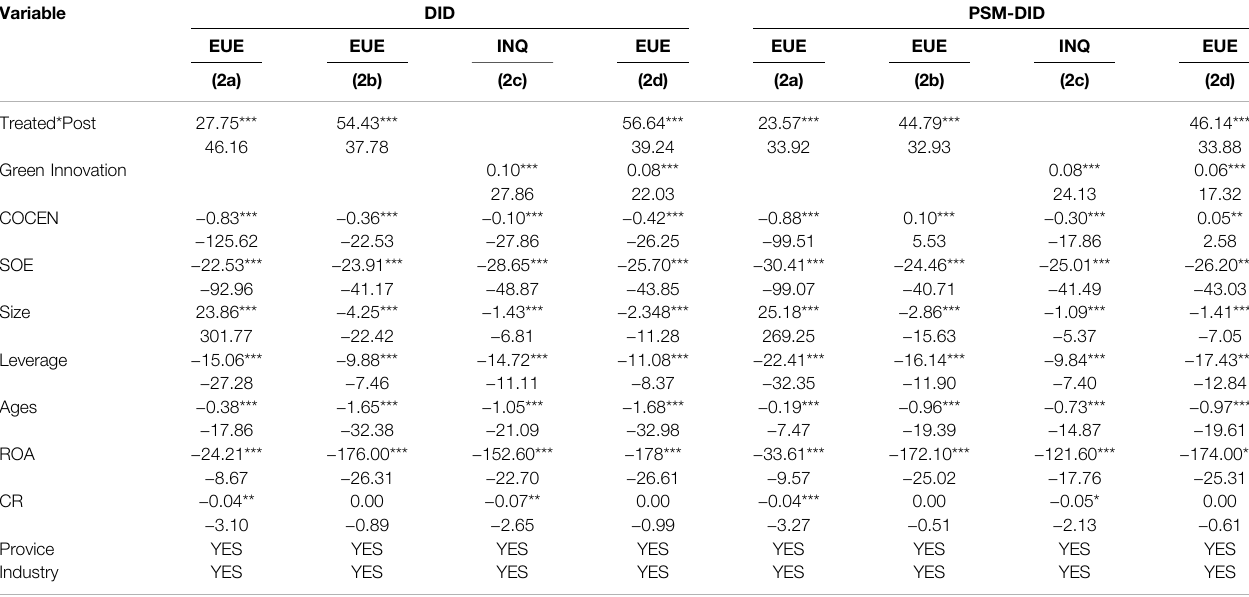
TABLE 8 | Environmental regulation induced effect regression results. Variable DID EUE EUE